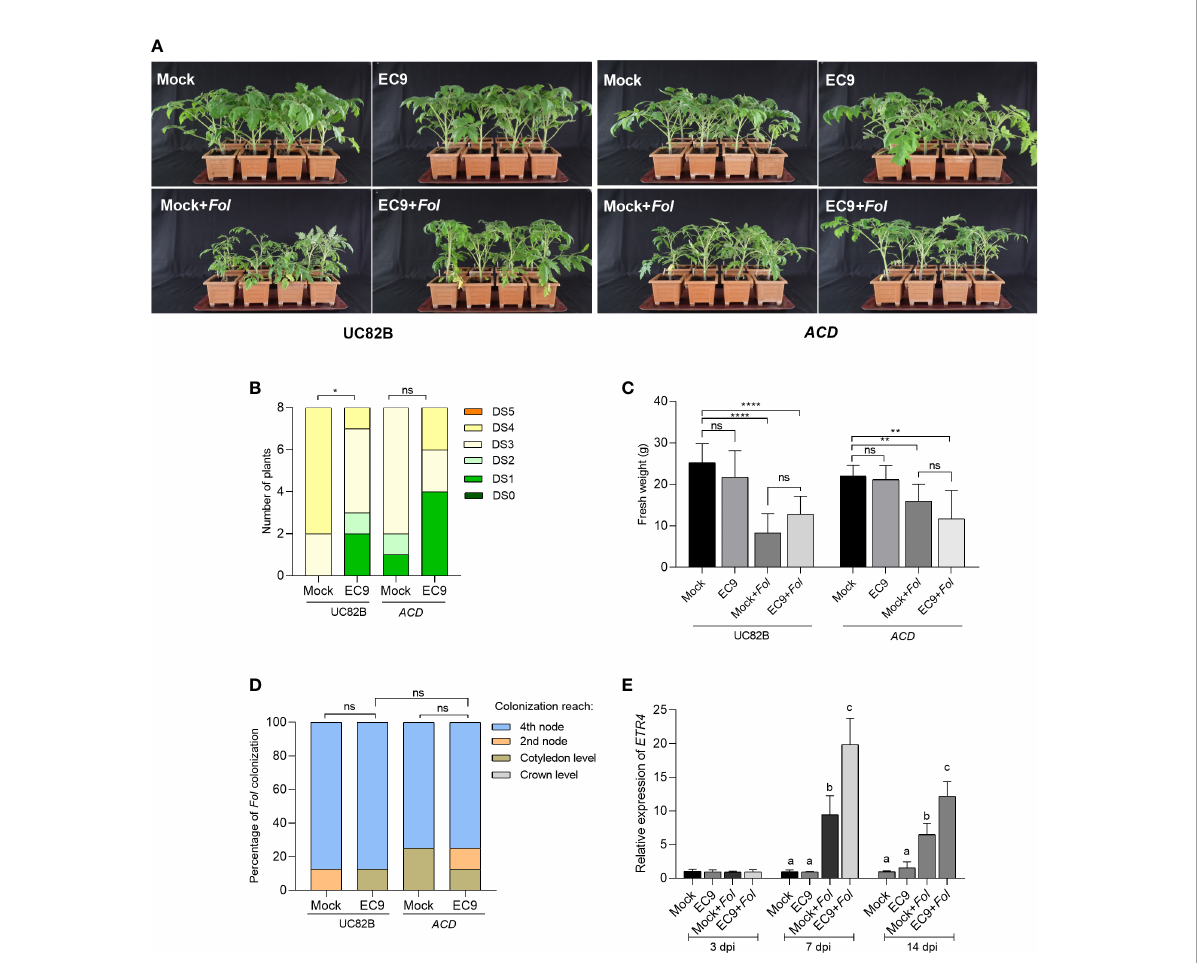
FIGURE 4 ET is involved in EC9-mediated enhanced defense against Fol. (A) Disease symptoms, (B) disease severity score, and (C) fresh weight of ACD transgenic line and the corresponding wild type cv. UC82B at 21 days post-inoculation (dpi) (n=8). Ten-days old tomato seedlings were treated with EC9 or 10 mM MgCl 2 (mock) by soil drenching and inoculated with Fol 1 week after treatment. (D) Percentage of Fol infected stem sections at 21 dpi (n=8). ns non-signi fi cant, * P < 0.05, ** P < 0.01, **** P < 0.0001. (E) The accumulation of transcripts of ethylene receptor 4 ( ETR4) in tomato plants (cv. Moneymaker) treated with EC9 or mock and inoculated with Fol was revealed by qRT-PCR (n=3). For gene expression analysis, stem pieces from the region between cotyledons and crown were harvested. The values were normalized to the internal reference transcript a -tubulin. Bars represent the means of the indicated number of biological replicates ± standard error. The experiments were repeated at least two times with similar results. Different letters indicate statistically signi fi cant differences between